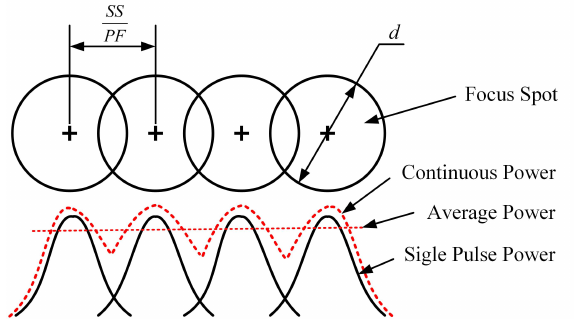
Figure 3. Schematic of laser pulses.